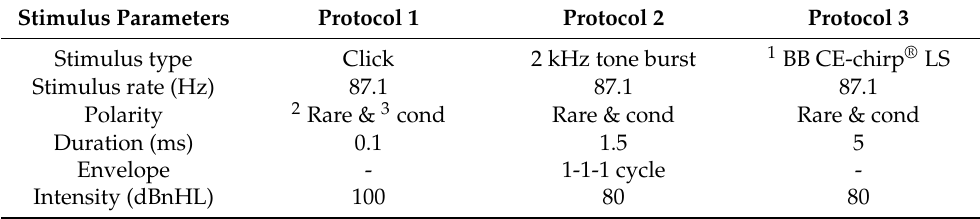
Table 1. Stimulus parameters for the CM protocols per stimulus type (click, 2 kHz tone burst and CE-chirp ® LS).